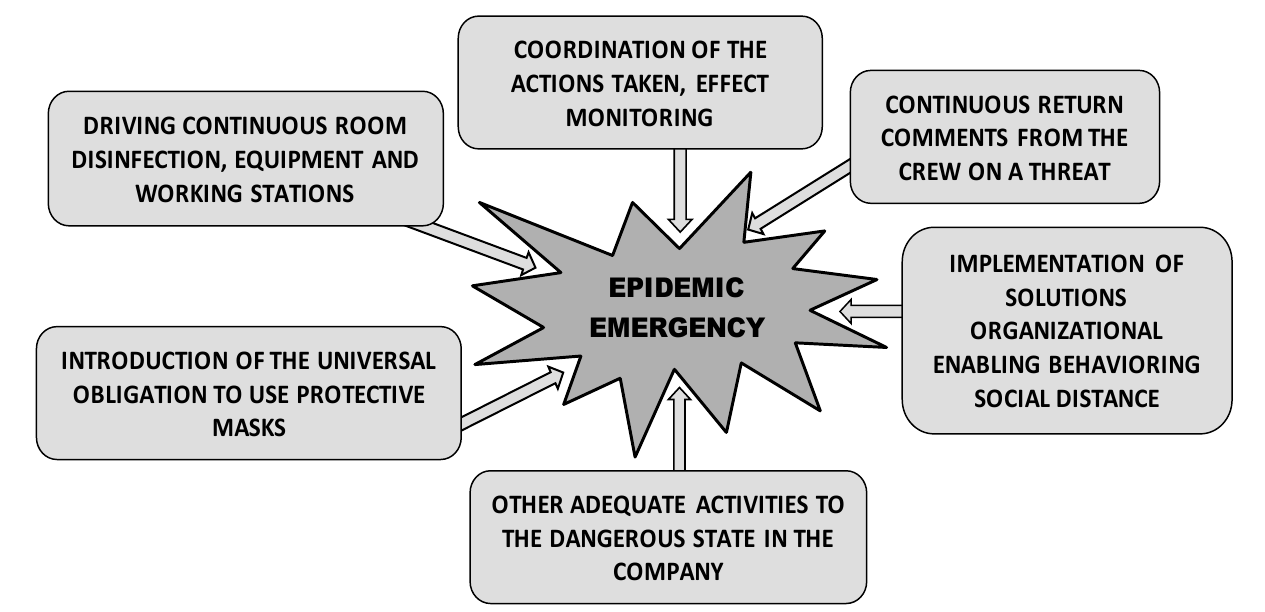
Figure 3. Actions taken to combat the epidemic threat in mines. Source: author’s own elaboration based on the research carried out in mining companies.